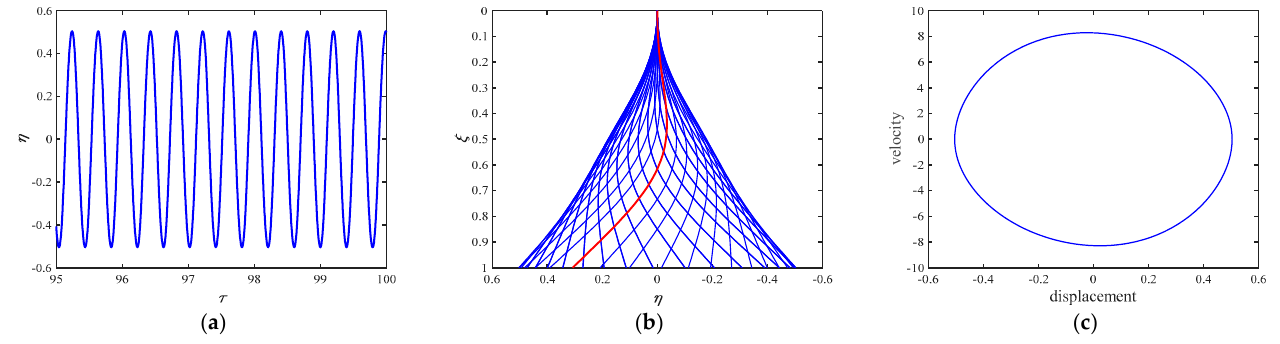
Figure 5. Dynamic response of the pipe with dry friction when u = 7.5: ( a ) Time history curve of the tip − end of the pipe; ( b ) oscillation shapes of the pipe; ( c ) phase portrait of the tip − end of the pipe.